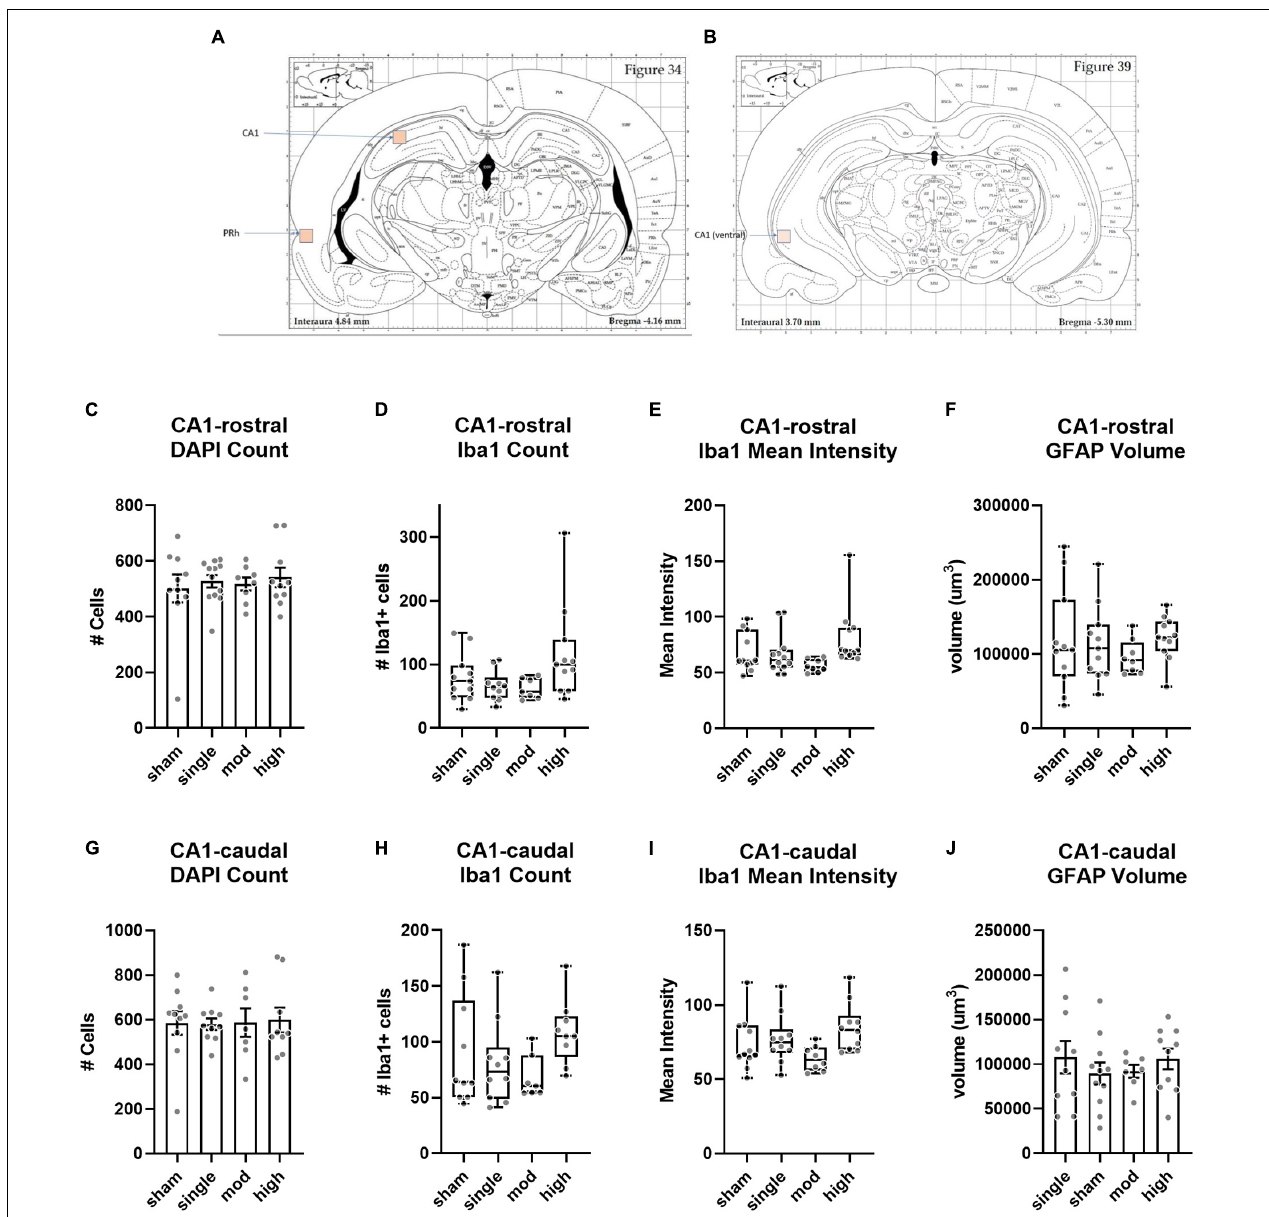
FIGURE 7 | Histopathology analysis of CA1 hippocampus. (A,B) Regions of interest (ROIs) used for analyses. (C–F) Rostral/dorsal CA1, (G–J) Caudal/ventral CA1. Bars represent mean ± SEM. Boxes/whiskers represent median, quartile, and range in non-normal